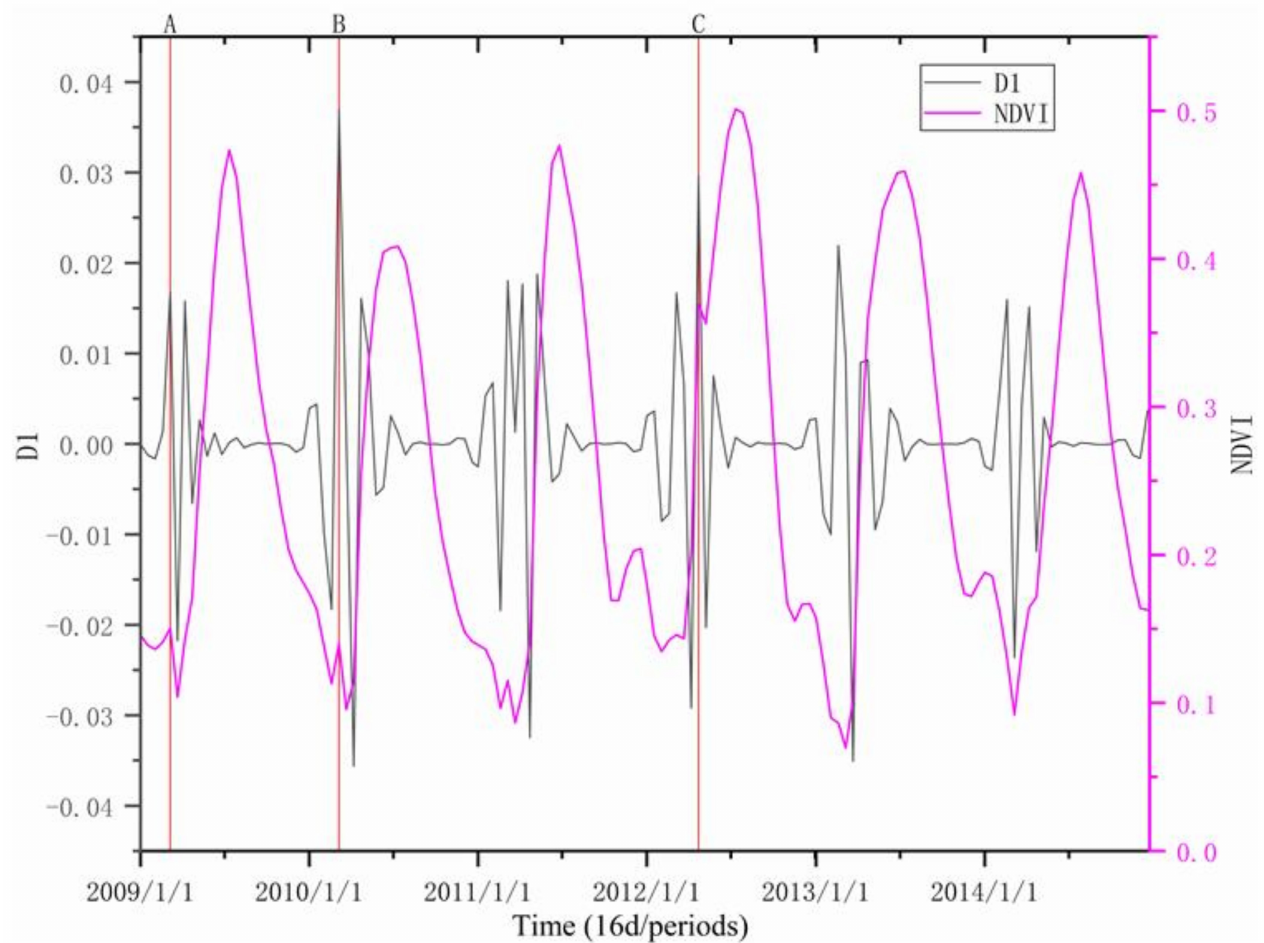
Figure 9. The D1 response to NDVI at Sampling Site 4. The left Y-axis is the value of the detail component D1, and the right Y-axis is the NDVI value. Reference lines A and B are in early March 2009 and 2010 respectively, C is in late April